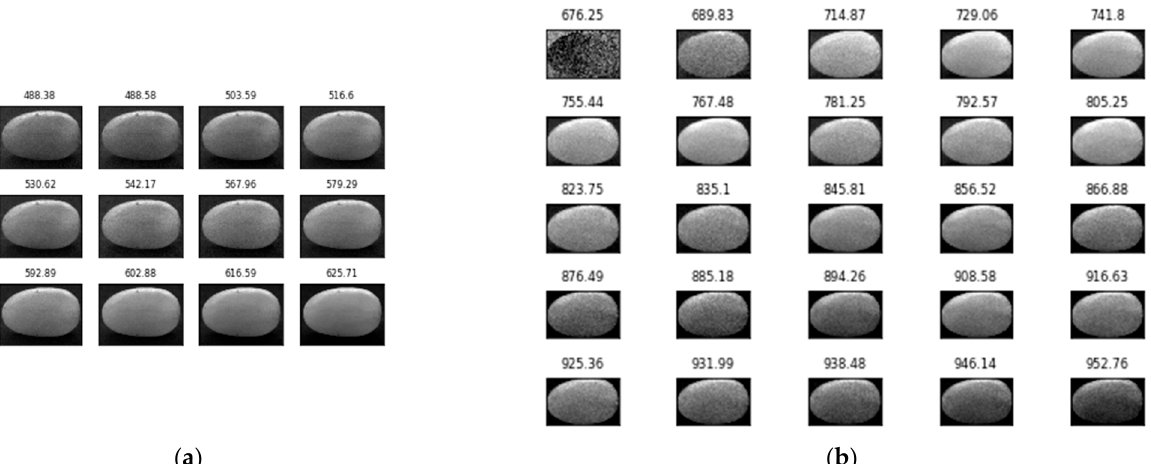
Figure 8. ( a ) 12 pre-processed bands obtained in the visible spectrum and ( b ) 25 pre-processed bands obtained in the IR spectrum. The numbers above the images correspond to the wavelength of image acquisition.